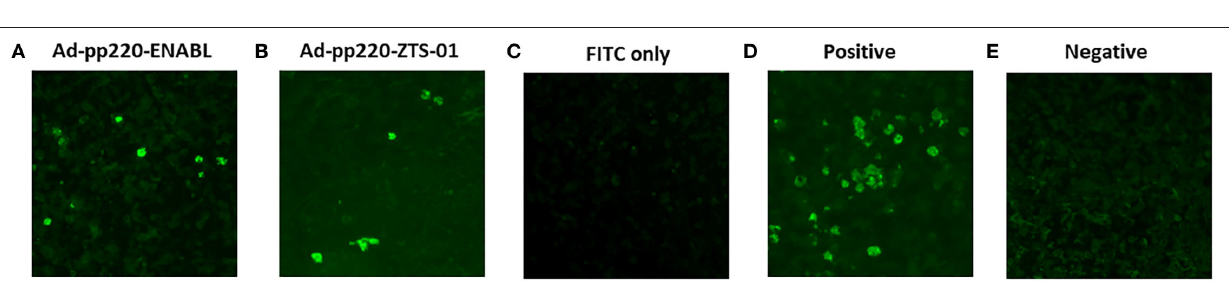
FIGURE 6 | Validation of Induced anti-pp220 antibodies: Authenticity of the antibodies elicited by the adenovirus-vectored pp220 antigens was confirmed by Immunohistochemistry. Formalin-fixed ASFV (Georgia 2007/1) infected swine spleen tissues were probed with sera that was obtained from each group two weeks post-boost: (A) Ad-pp220-ENABL; (B) Ad-pp220-ZTS-01; (C) Secondary (FITC) antibody control: secondary antibody is probed in the absence of primary sera, (D) Positive control serum: ASFV specific convalescent swine serum, and (E) Negative control serum: